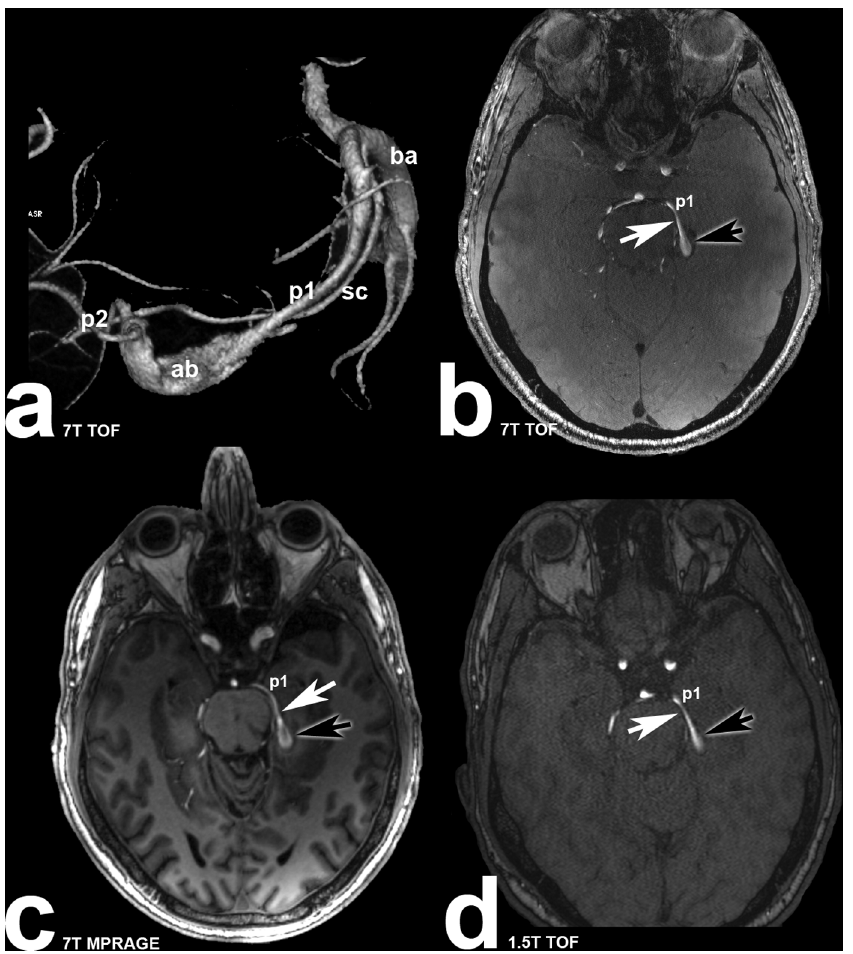
Figure 2. Forty-five years old male patient (subject 6) with partially thrombosed left sided fusiform posterior cerebral artery aneurysm. White arrows are marking the aneurysm neck, black arrows are marking the aneurysm dome. p1: posterior cerebral artery (p1 segment) a: Volume rendering of the 7 Tesla TOF MRA illustrating the three dimensional structure of the aneurysm (ba: basilar artery; sc: superior cerebellar artery; p2: posterior cerebral artery (p2 segment); ab: aneurysm body); b: transverse plane of the 7 Tesla TOF MRA depicting the parent vessel and part of the aneurysm body; c: Excellent delineation of parent vessel and part of the aneurysm body in 7 Tesla MPRAGE scan; d: Moderate depiction of parent vessel and aneurysm body in 1.5 Tesla TOF MRA.